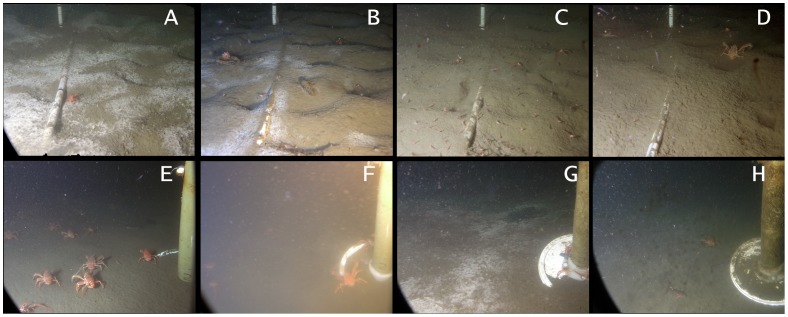
Photos of study area at the Digital Camera Platform VENUS location in Saanich Inlet.The pictures show bacterial mats and megafauna. A. Oct 6′09– Medium Munida on dense mat; thick bands on white scale are 10 cm apart. B. Nov 18′09– Tiny Spirontocaris, large Munida, Lyopsetta in pits created by the flatfish (and a fir cone); note diminishing mat. C. Dec 14′09– Maximum Spirontocaris abundance; medium Munida and one Lyopsetta in the image. D. Feb 12′10– Large Munida on a smoothed seafloor with no mat; zooplankton include euphausiids and amphipods. E. Apr 1′10– Abundant large and medium Munida beside camera leg. F. May 28′10– Image illustrates a turbid event (caused by resuspended sediment) that obscures distal areas. G. Jul 10′10– Seafloor has diatom layer and bacterial mat; the black area is lifted mat that reveals likely sulphidic sediment. Small Munida on camera foot where animal activity has cleared the sediment. H. Sep 24′10– Visibility now reduced by biofilm on camera.